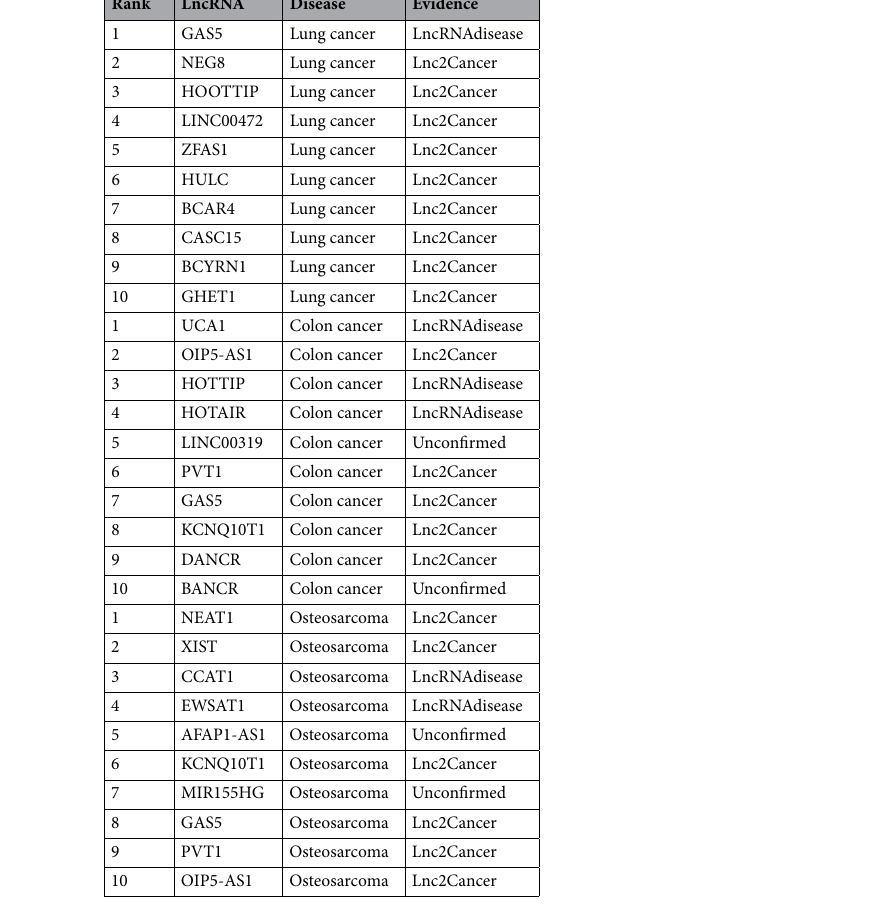
Table 2. The top 10 predicted lncRNAs associated with lung cancer, colon cancer, osteosarcoma.